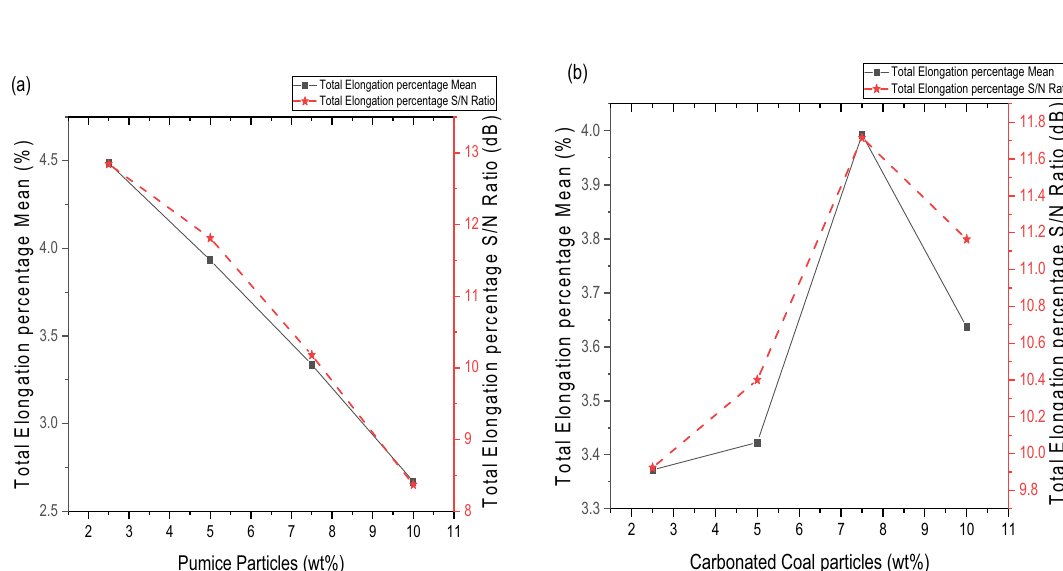
Figure 4. Variation of percentage elongation with reinforcement addition; ( a ) pumice powder vs percentage elongation, ( b ) carbonated coal particles vs percentage